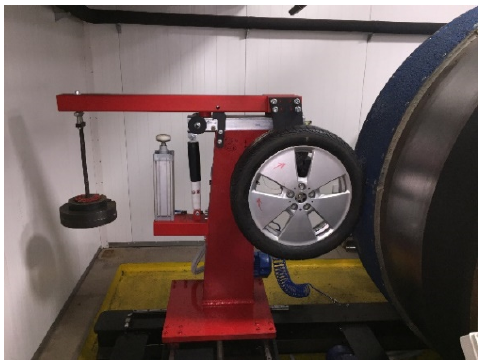
Figure 3. Roadwheel facility for tire rolling resistance measurements.